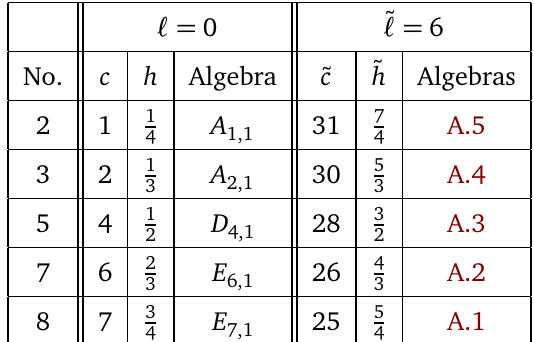
(cid:96) = 0 ˜ (cid:96) =